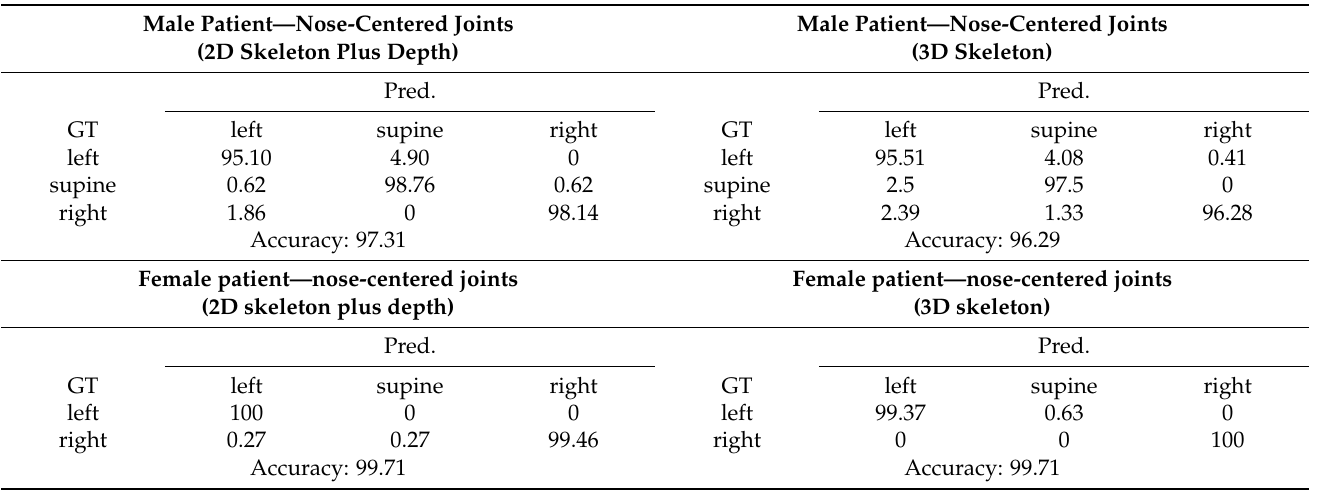
Table 9. Accuracy and confusion matrix (all numbers in terms of %) for Setting